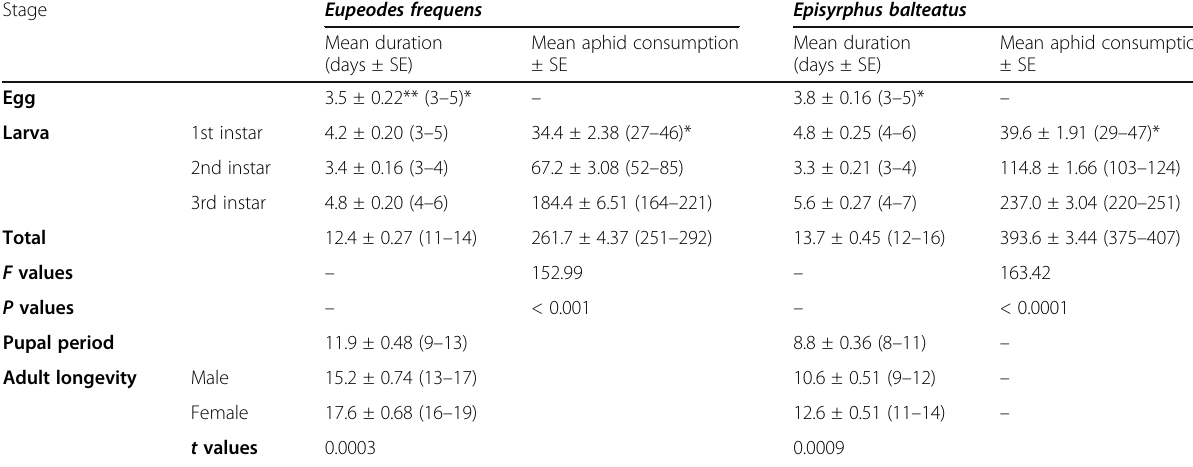
Table 1 Duration of different developmental stages and predatory potential of Eupeodes frequens Stage